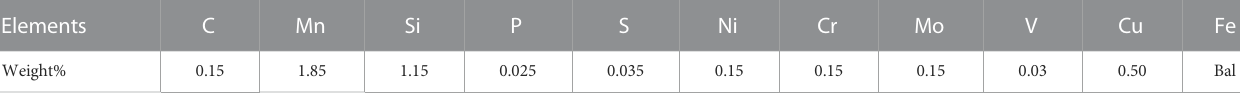
TABLE 1 Chemical composition of the ER70S-6 mild steel wire (Warsi et al., 2022). Elements